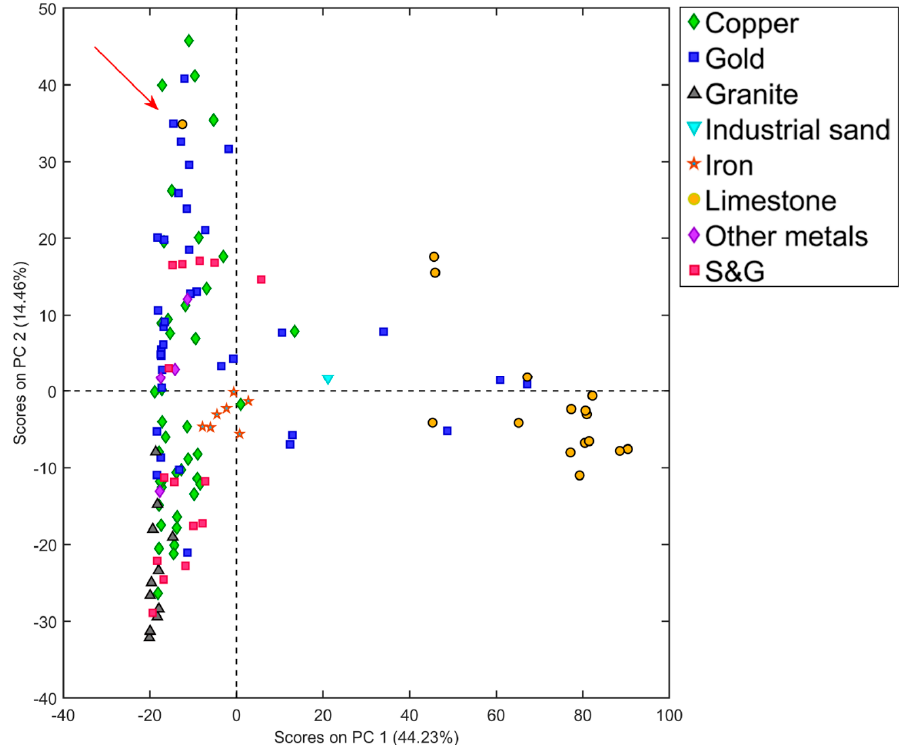
Figure 3. Sample scores on PC1 v. sample scores on PC2 from the PCA model of the XRD dataset, unique limestone sample indicated by arrow, confidence ellipses removed for clarity.